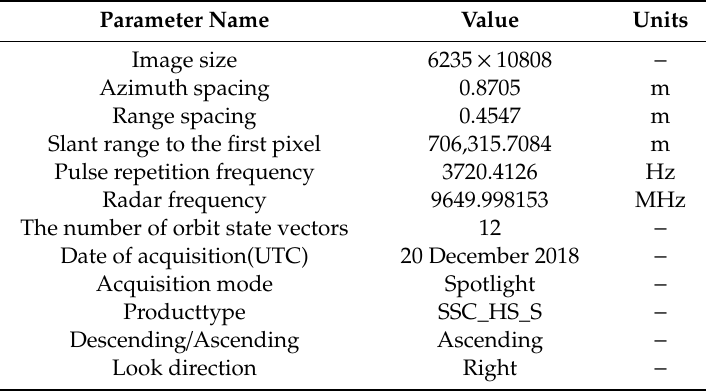
Table 1. TanDEM-X’s